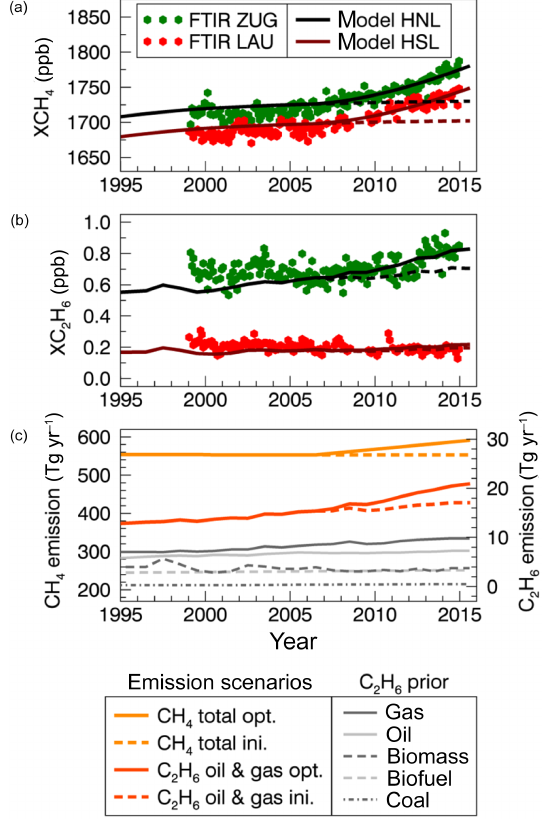
Figure 3. Methane and ethane two-box model: (a) monthly mean column-averaged methane and (b) ethane from Zugspitze and Lauder FTIR observations. Modeled annual means of XCH 4 and XC 2 H 6 are shown for high northern and southern latitudes (HNL, HSL) after emission optimization (solid lines) and with prior emis- sions (dashed lines). An overall offset is applied to the modeled time series to fit the observed average for 2007–2014. (c) Emission sce- nario for 2007–2014: optimized global emissions of methane (“CH 4 total opt.”, left y axis) and ethane from oil and natural gas sources (“C 2 H 6 oil & gas opt.”, right y axis). For comparison, the corre- sponding initial emission histories are displayed along with prior ethane emissions of all considered source